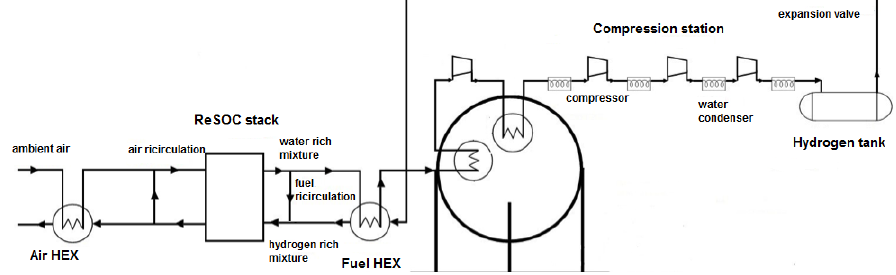
Figure 4. Condensed vapor plant configuration in SOFC mode.